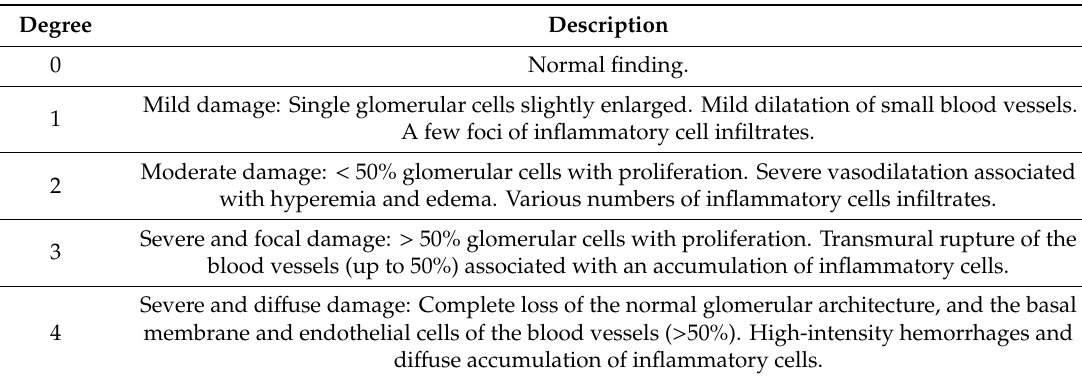
Table 2. Tissue scoring scale for renal alterations—Renal Damage Score